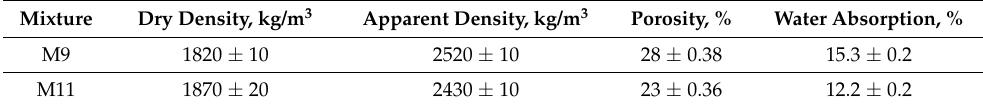
Table 4. Physical properties for pastes M9 y M11 with 100%